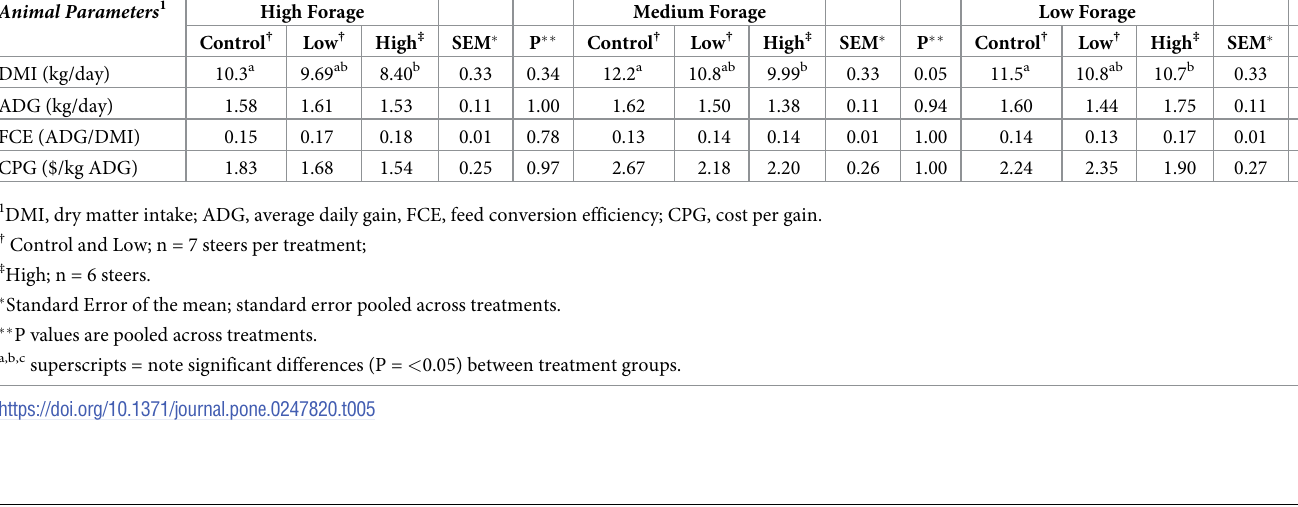
Table 5. Effect of Asparagopsis taxiformis inclusion at 0.25% (Low) and 0.5% (High) feed organic matter on beef animal parameters using high, medium-, and low- forage diets. Animal Parameters